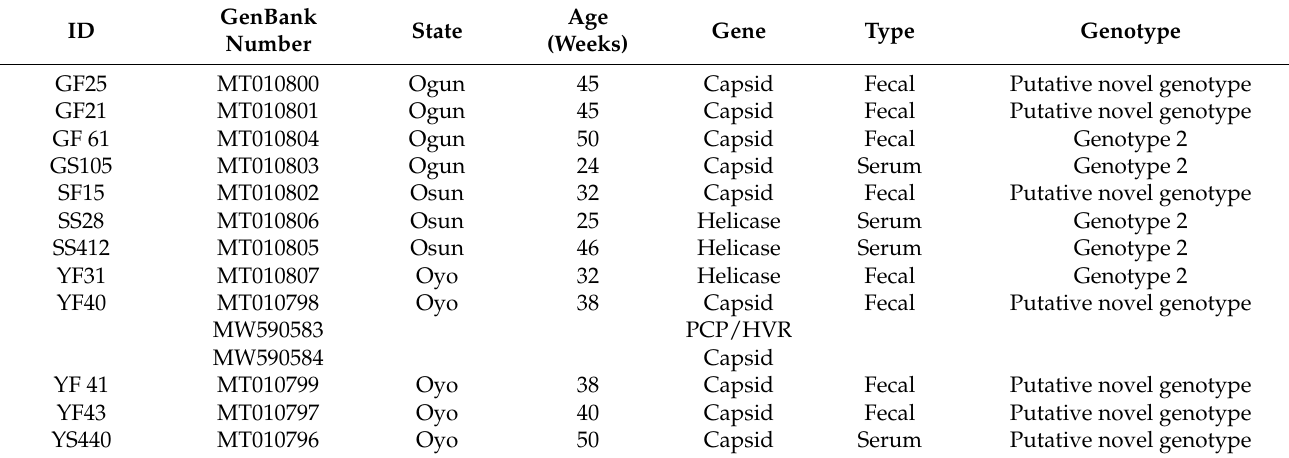
Table 3. Characteristics of the sequenced isolates from this